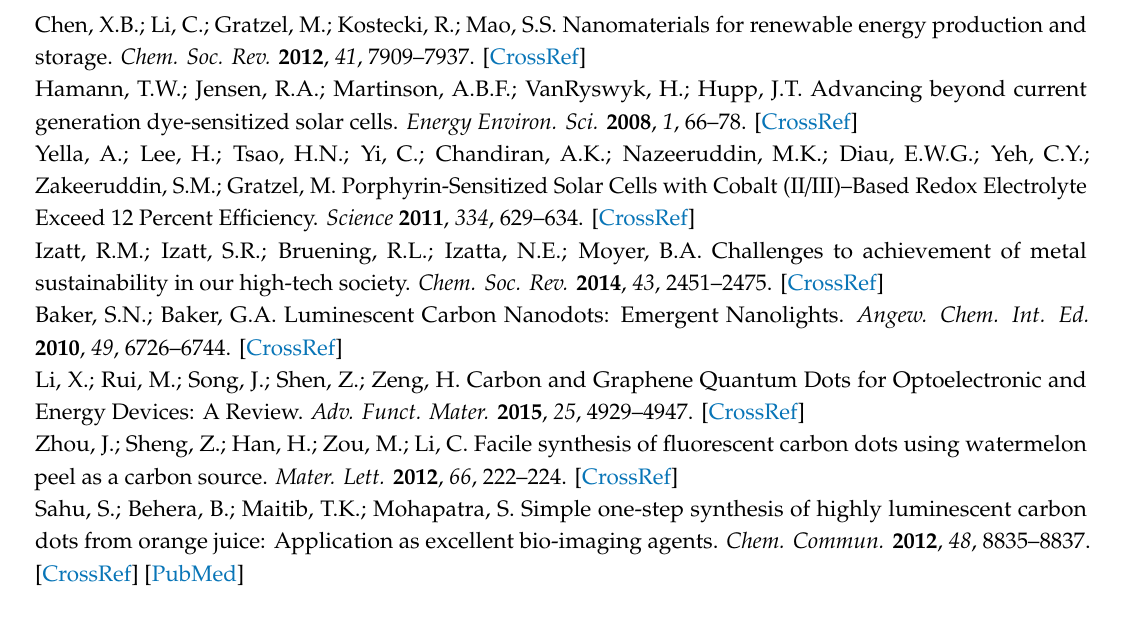
Figure S1: The chemical structure of the N719 dye; Figure S2: The high resolution TEM micrograph of N-CQDs at 0.5 h, 2 h and 8 h heating times; Figure S3: Average power conversion e ffi ciencies of various N-CQDs tailored QDSSCs; Figure S4: The high resolution TEM micrograph of optimized N-CQDs; Figure S5: Cyclic voltammograms for N-CQDs at 2 h heating time; Figure S6: The energy level of N-CQDs with di ff erent heating times; Figure S7: The UV-vis di ff use reflectance absorption spectra of TiO2, TiO2 / N719 and TiO2 / N719 / N-CQDs; Figure S8: Error bars of the DSSCs with or without N-CQDs, the standard deviation among 15 measurements for the same device; Figure S9: The absorption spectrum of N719 dye (black line) and emission spectra of N-CQDs (blue line) upon excitation at 390 nm, in order to support the FRET mechanism; Table S1: The comparsion date about as-prepared CQDs outstanding advantages other kinds of carbon dots sensitized solar cells reported previously as light absorbers; Table S2: Electrochemical parameters for N-CQDs sensitized solar cells; Table S3: The comparsion date about the co-sensitized solar cells reported previously; Table S4: Electrochemical parameters for co-sensitized solar